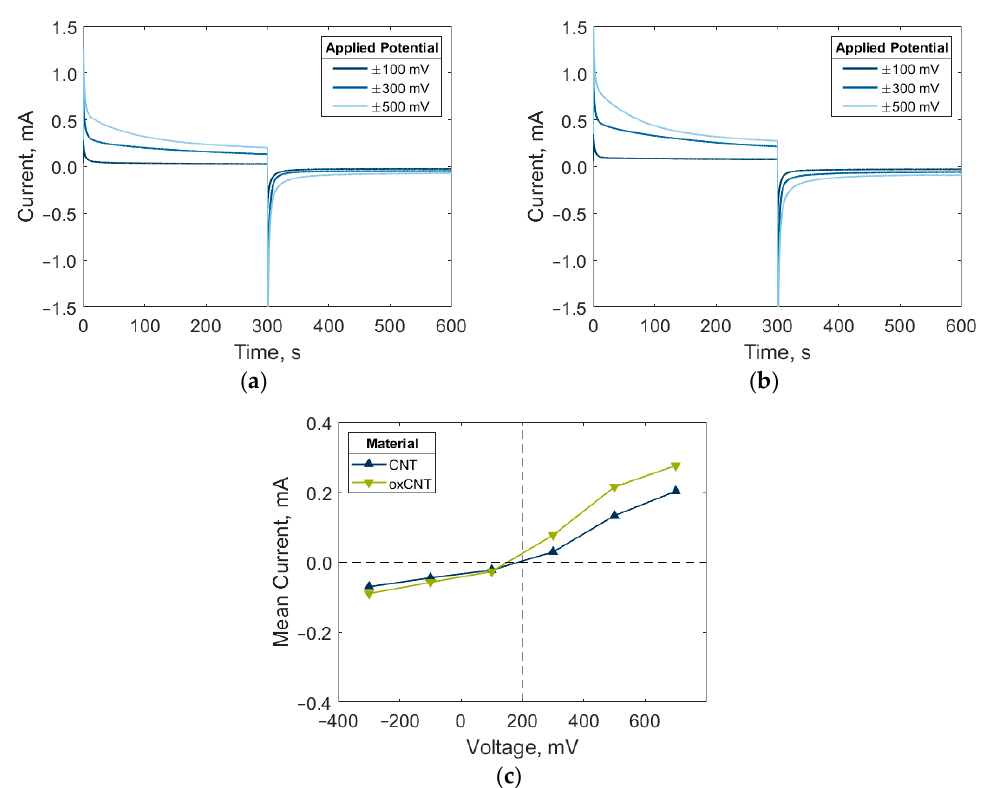
Figure 7. Chronoamperometry experiments for untreated ( a ) and oxidized ( b ) CNT-K monoliths. The calculated resulting mean current after EDL rearrangement for both materials is presented in ( c ).